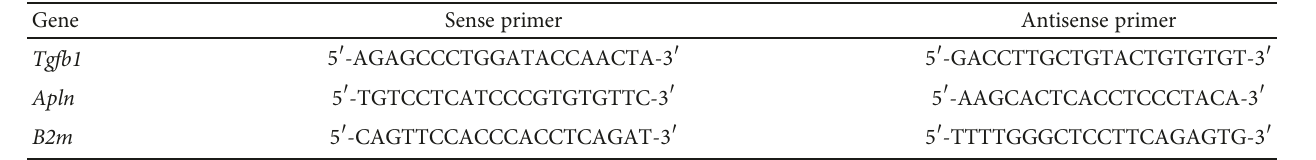
Table 1: The sequences of the